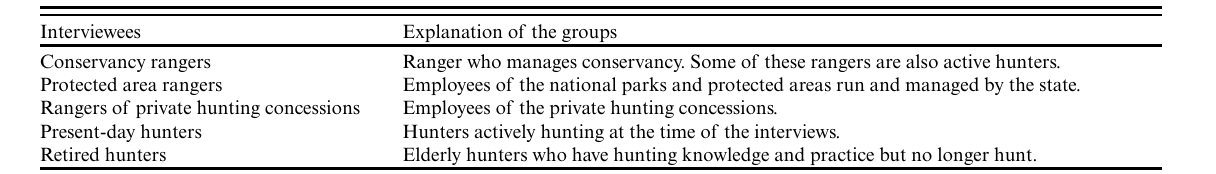
Table 1 . Definition of the interviewed groups.